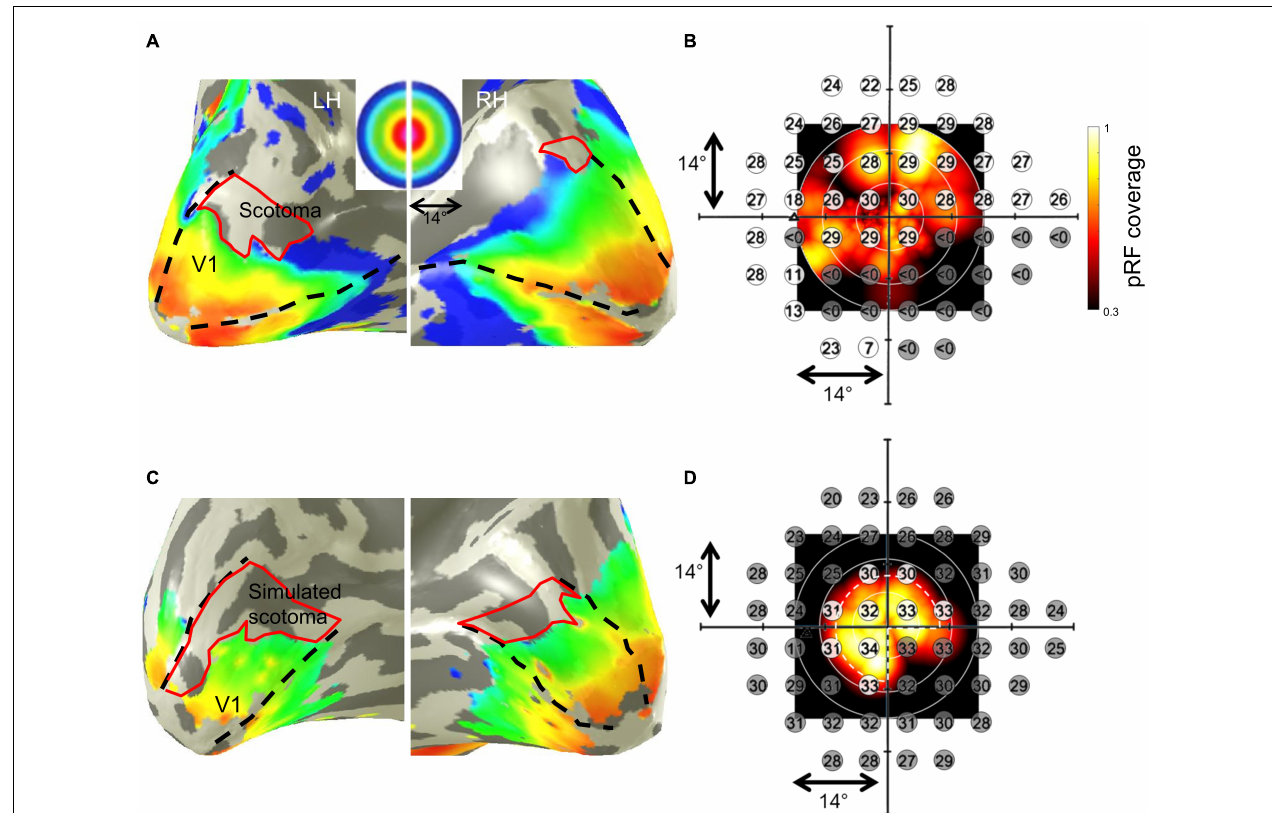
FIGURE 1 | Population receptive field (pRF) mapping derived eccentricities of a representative glaucoma participant (GL1; stimulation of left eye) with lower VF-defect (scotoma) (A) and a control (HC5; stimulation of left eye) with simulated peripheral ( > 7 ◦ ) and lower right quadrant scotoma (C) mapped on their subjective inflated right and left visual cortex, respectively. Dashed black lines in panels (A,C) illustrate the primary visual cortex V1 boundaries. False-color representation from dark orange to dark blue illustrates the retinotopic progression of eccentricities from 0 ◦ to 14 ◦ . Restricted representations are visualized in the regions of the cortex corresponding to the VF-deficits (depicted by the red borders). Panels (B,D) show the subjective VFs predicted by SAP overlaid on the pRF-based VF coverage map of the glaucoma patient and control, respectively. In panel (B) , sensitivity < 0 dB (indicated by gray discs) indicates absolute scotoma location in the glaucoma participant. In panel (D) , the white dashed pie represents the boundary of stimulated VF in the controls; the simulated scotomatous VF locations are indicated by the gray discs in the control. The superimposed plots clearly demonstrate the correspondence between the SAP-based and pRF-based VF-reconstructions for both, patient and